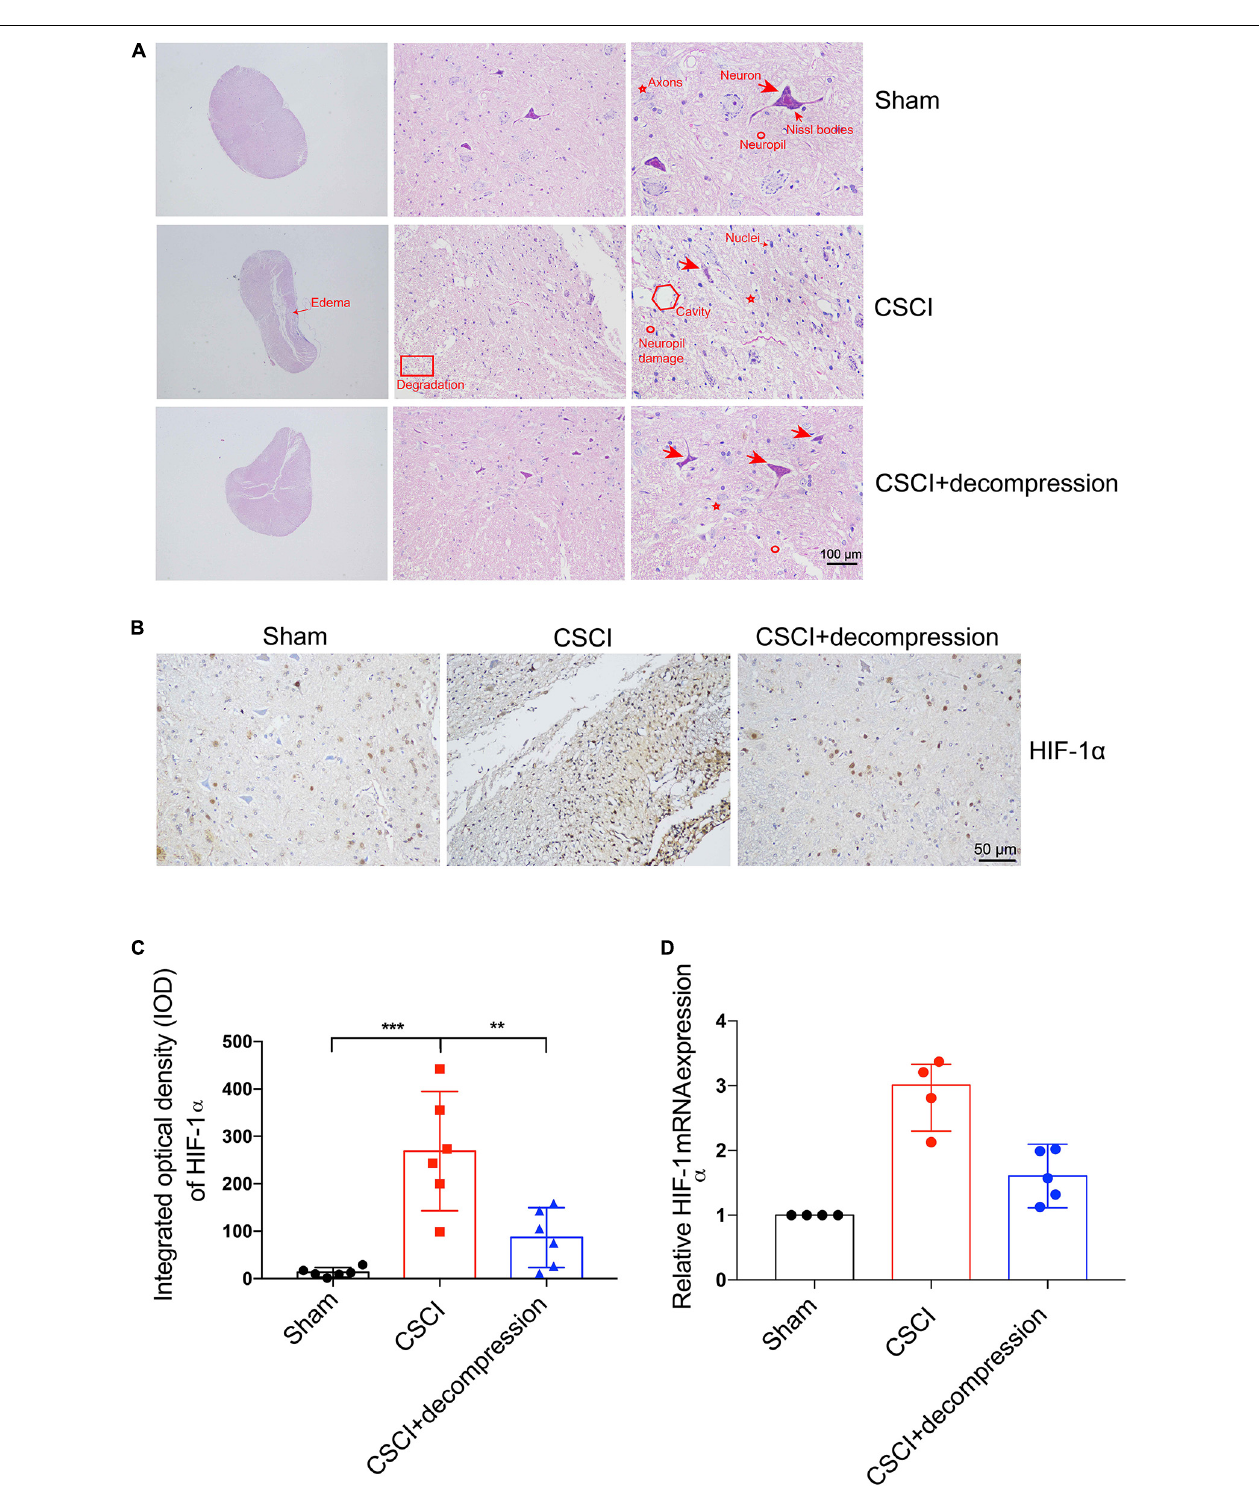
FIGURE 3 | Decompression-protected neurons and improved hypoxia environment after CSCI. (A) HE staining of lesion sites from the sham, CSCI, and CSCI with decompression groups (20 × , 200 × , and 400 × magnification; scale bar, 100 µ m). (B) HIF-1 α expression, as assessed by IHC (200 × magnification; scale bar, 50 µ m). (C) HIF-1 α IHC staining, as quantitated by the IOD [One-way ANOVA, F (2,15) = 17.18, p < 0.001; Tukey post hoc : *** p < 0.001, ** p = 0.003]. (D) Relative HIF-1 α expression, as determined by RT-qPCR. HE staining and IHC: n = 6 each group; Mean ± 95% CI. RT-qPCR: the Sham group: n = 4; CSCI group: n = 4; CSCI with decompression group: n = 5; Medians ± interquartile ranges, the sample size was too low to perform statistics for these data.